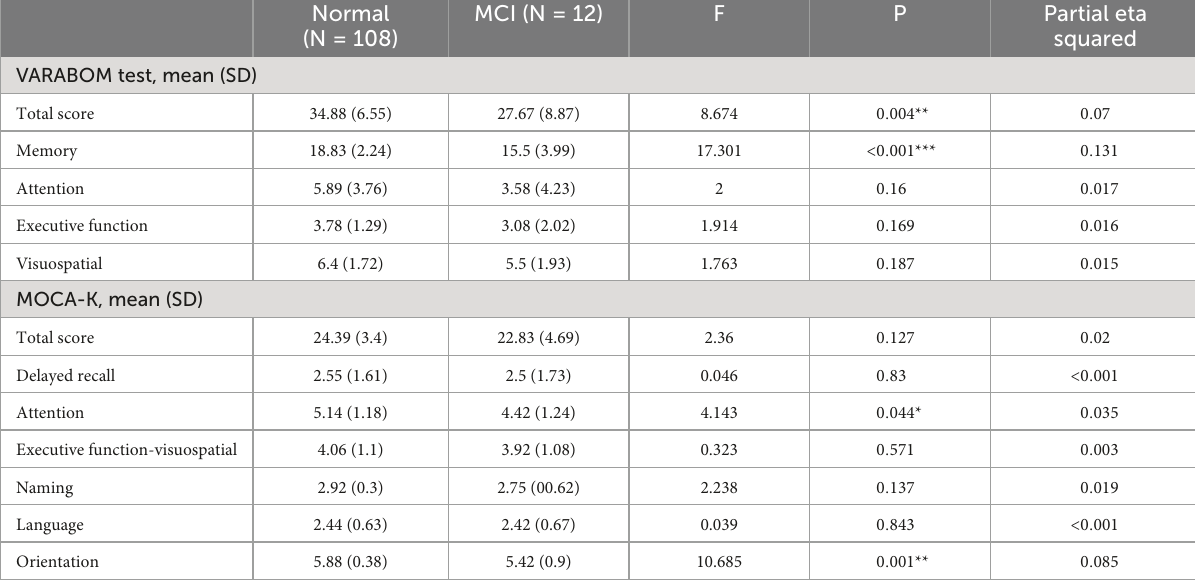
TABLE 3 Scores of VARABOM test and MOCA-K assessment by group.